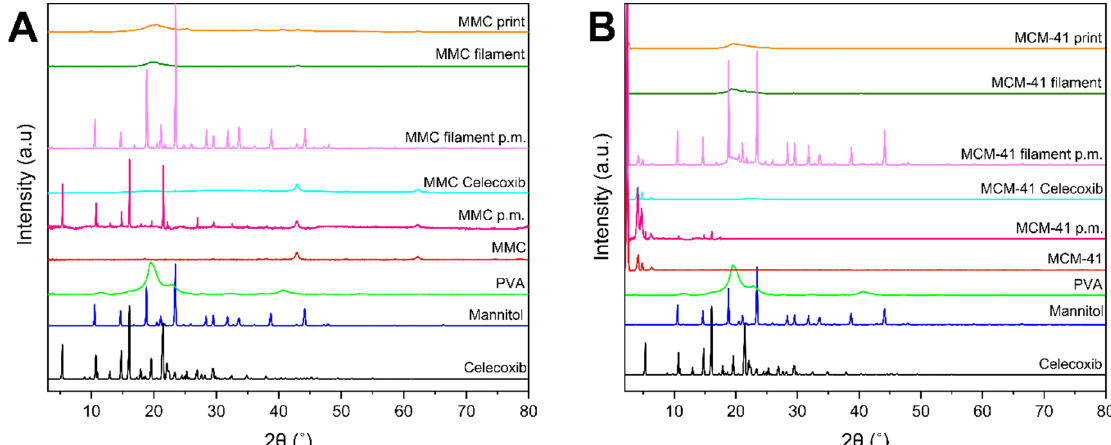
Figure 4. XRD diffractograms of filaments, tablets, and individual components; ( A ) MMC-containing formulations: MMC p.m. is the physical mixture of MMC and celecoxib, MMC Celecoxib is drug-loaded MMC, and MMC filament p.m. is the physical mixture of the filament components; ( B ) MCM-41-containing formulations: MCM-41 p.m. is the physical mixture of MCM-41 and celecoxib, MCM-41 Celecoxib is drug-loaded MCM-41, and MCM-41 filament p.m. is the physical mixture of the filament components.